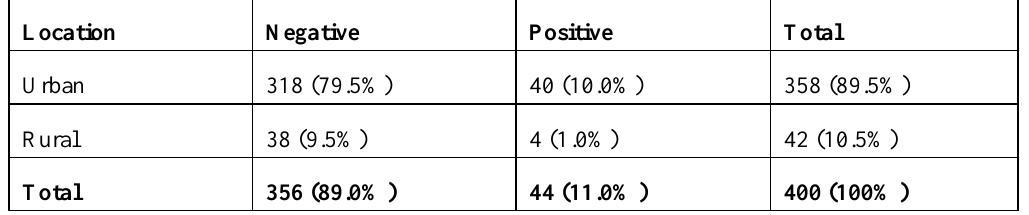
Table 4. Association between location and hepatitis B Status among pregnant women in Ilorin.